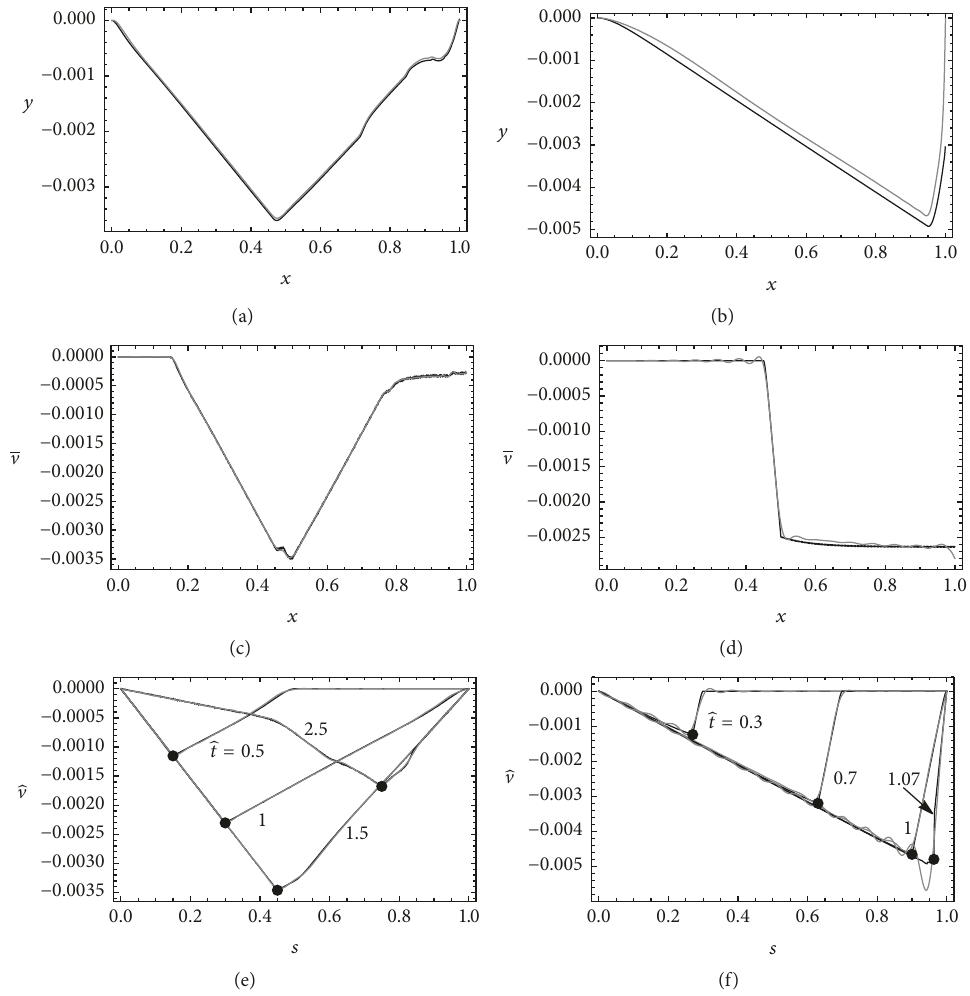
Figure 2: Comparison between the integral approach (black lines) and the Galerkin approach (gray lines), when 𝑃 = 0.01 and 𝜇 = 0.1 ; 𝑁 = 30 : (a), (c), (e) 𝑈 = 0.3 and 𝑁 = 6000 ; (b), (d), (f) 𝑈 𝑒 0 𝑠 respectively.